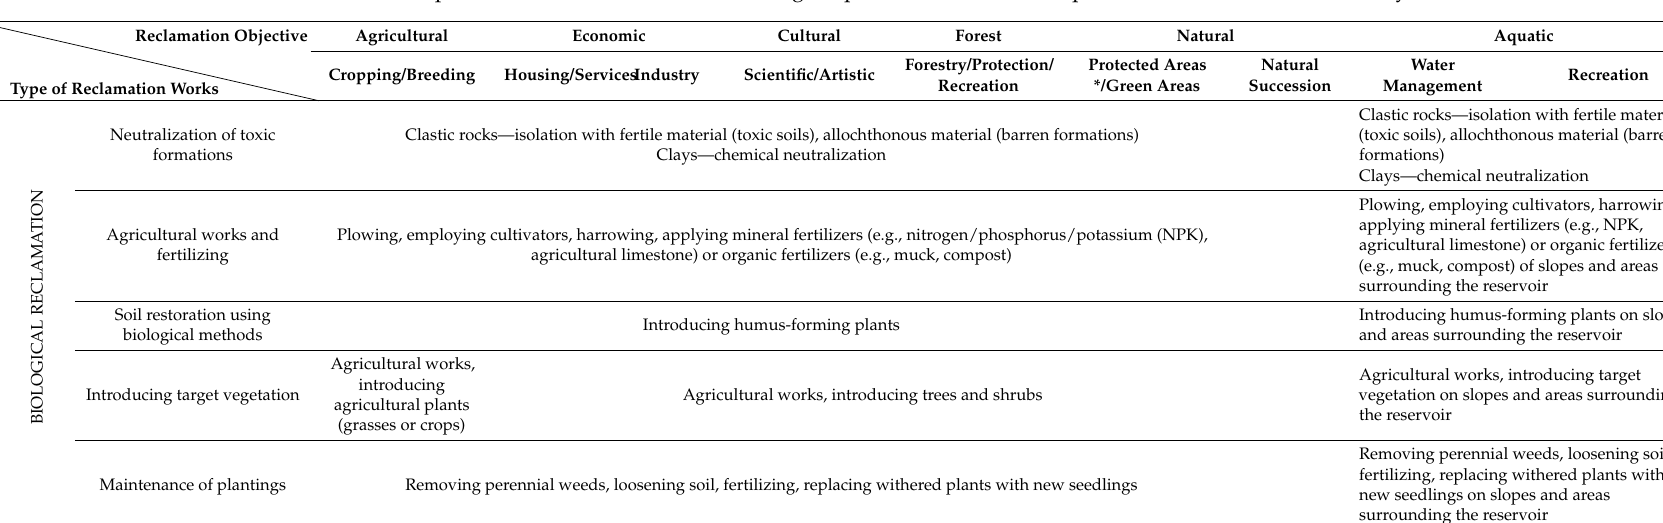
Table 3. The scope of reclamation works of the biological phase for areas after exploitation of clastic rocks and